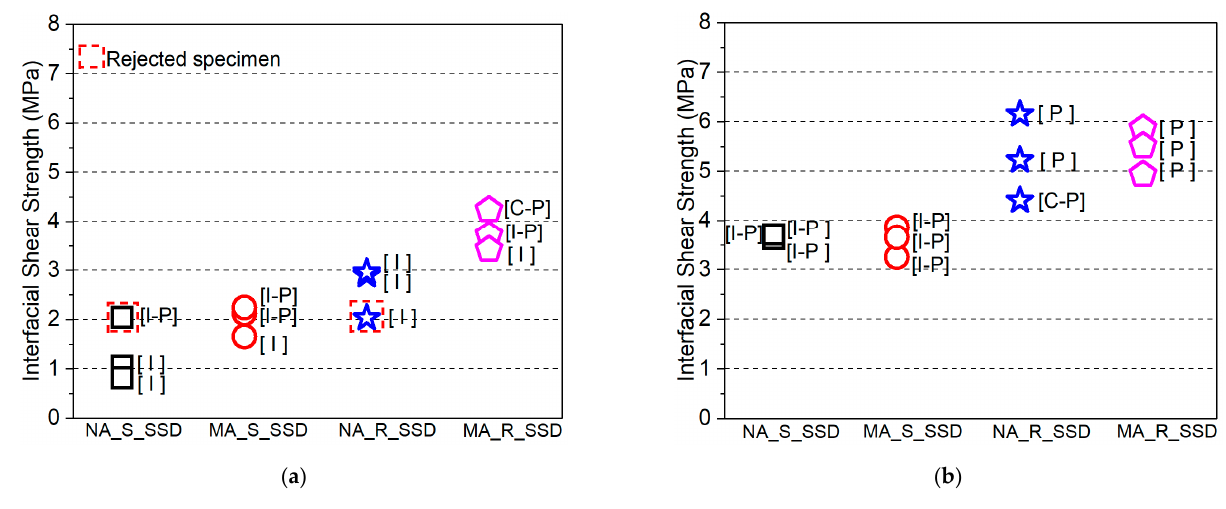
Figure 12. Fracture mode with corresponding interfacial shear strength of all the composite specimens. ( a ) Without primer, ( b ) with